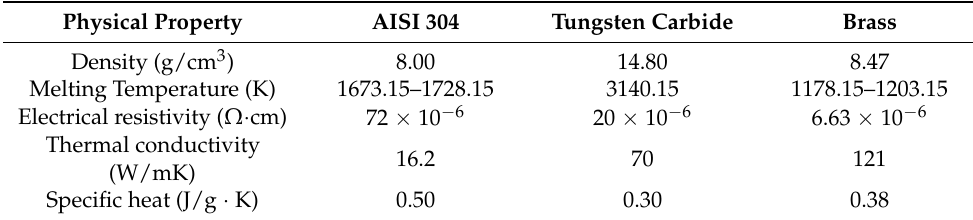
Table 2. Micro-EDM main process parameters.